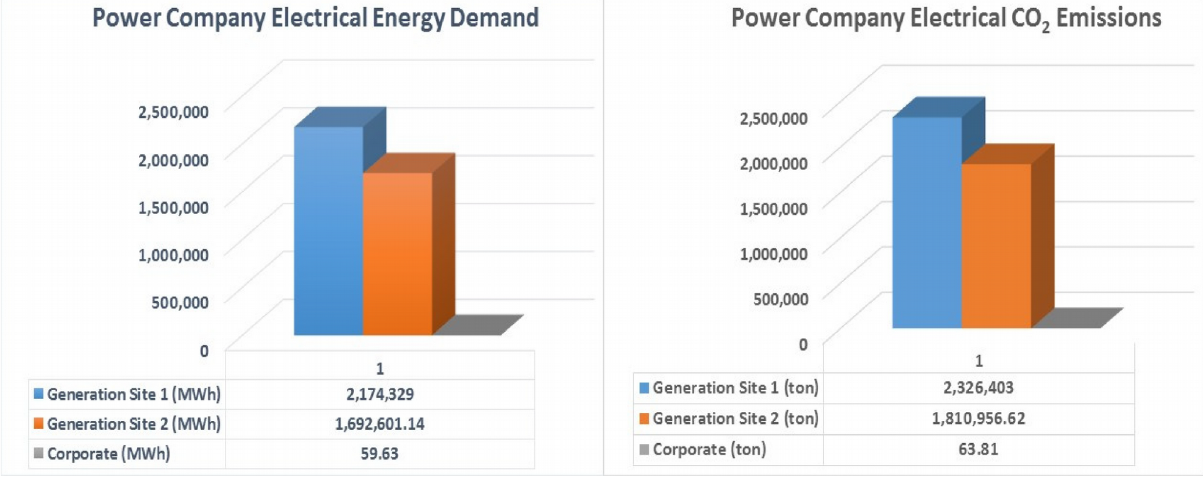
emissions of each site 2